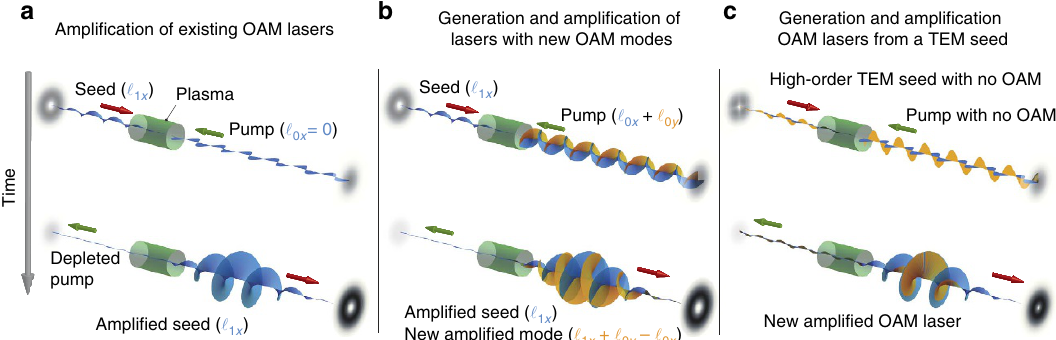
Figure 1 | Generation and amplification of OAM lasers via stimulated Raman backscattering. In Raman amplification, a long pump laser transfers its energy to a short, counter-propagating seed laser in a plasma. The process depletes the pump laser pulse energy and enhances the intensity of the seed laser. The seed/pump lasers propagate in the direction of the red/green arrow, respectively. Polarization in the x / y direction is represented by blue/orange lasers, respectively. The position of the plasma, relative to the seed and pump lasers, is shown by the green cylinders. The back/front projections show the intensity profile of the closest laser. ( a ) A set-up leading to the amplification of a seed with OAM. ( b ) The generation and amplification of new OAM modes. ( c ) The generation and amplification of a new OAM laser in a configuration with no initial